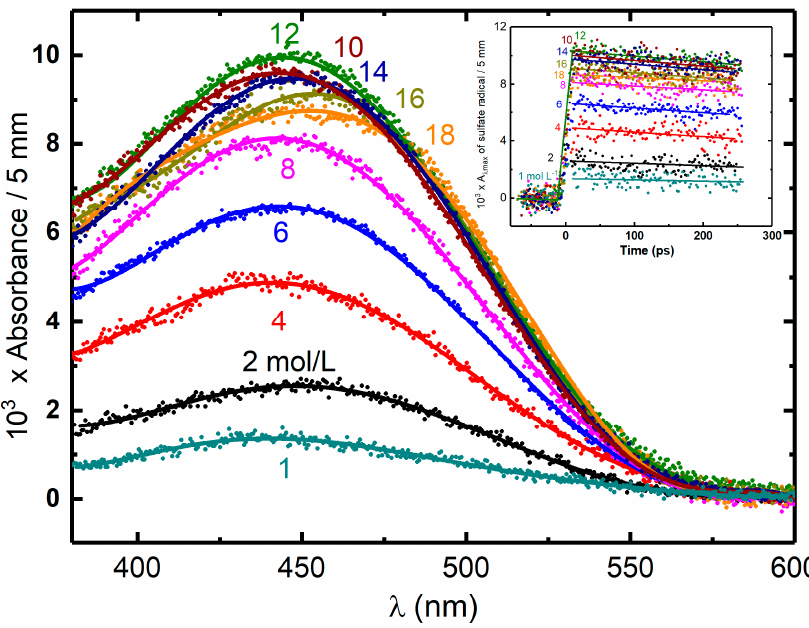
Figure 6. Transient absorption spectrum of SO 4 •− or HSO 4 •− at maximum of absorption versus concentration of acid observed immediately after 7 ps electron pulse. Insert figure shows the corresponding transient kinetics of SO 4 •− or HSO 4 •− . The contribution of solvated electron in 1 to 6 mol L − 1 H 2 SO 4 is subtracted from the signal based on the known extinction coefficient at various wavelengths. The energy deposited in concentrated acidic solutions D sol is higher comparing with neat water because of direct radiolysis of the solutes in the presence of the system. The effective dose considering this contribution can be derived from the reference dose in pure water D water as follows: D sol ( JL − 1 ) = FD water ( Jkg − 1 ) The dose factor ( F ) can be estimated by the following equation: + Z water ( 100 − p ) / A water )( Z water 100/ A water ) − 1 , where d F = d sol ( Z p / A H sol is the density of SO 2 − 4 2 SO 4 the solution, Z is the number of electrons, A is the mass number, and p is the weight fraction of the solute percent. The dose was 31.3 Gy per pulse. Adapted from [43].